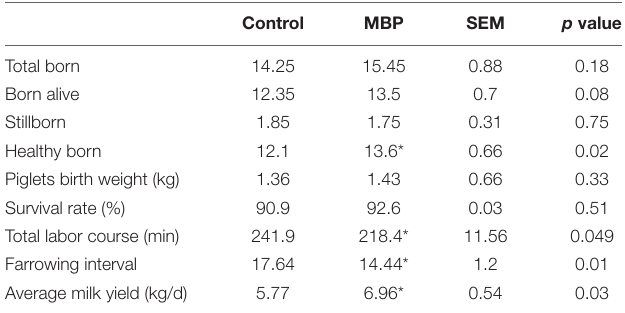
TABLE 1 | Sow performance during lactation fed a standard diet without or with